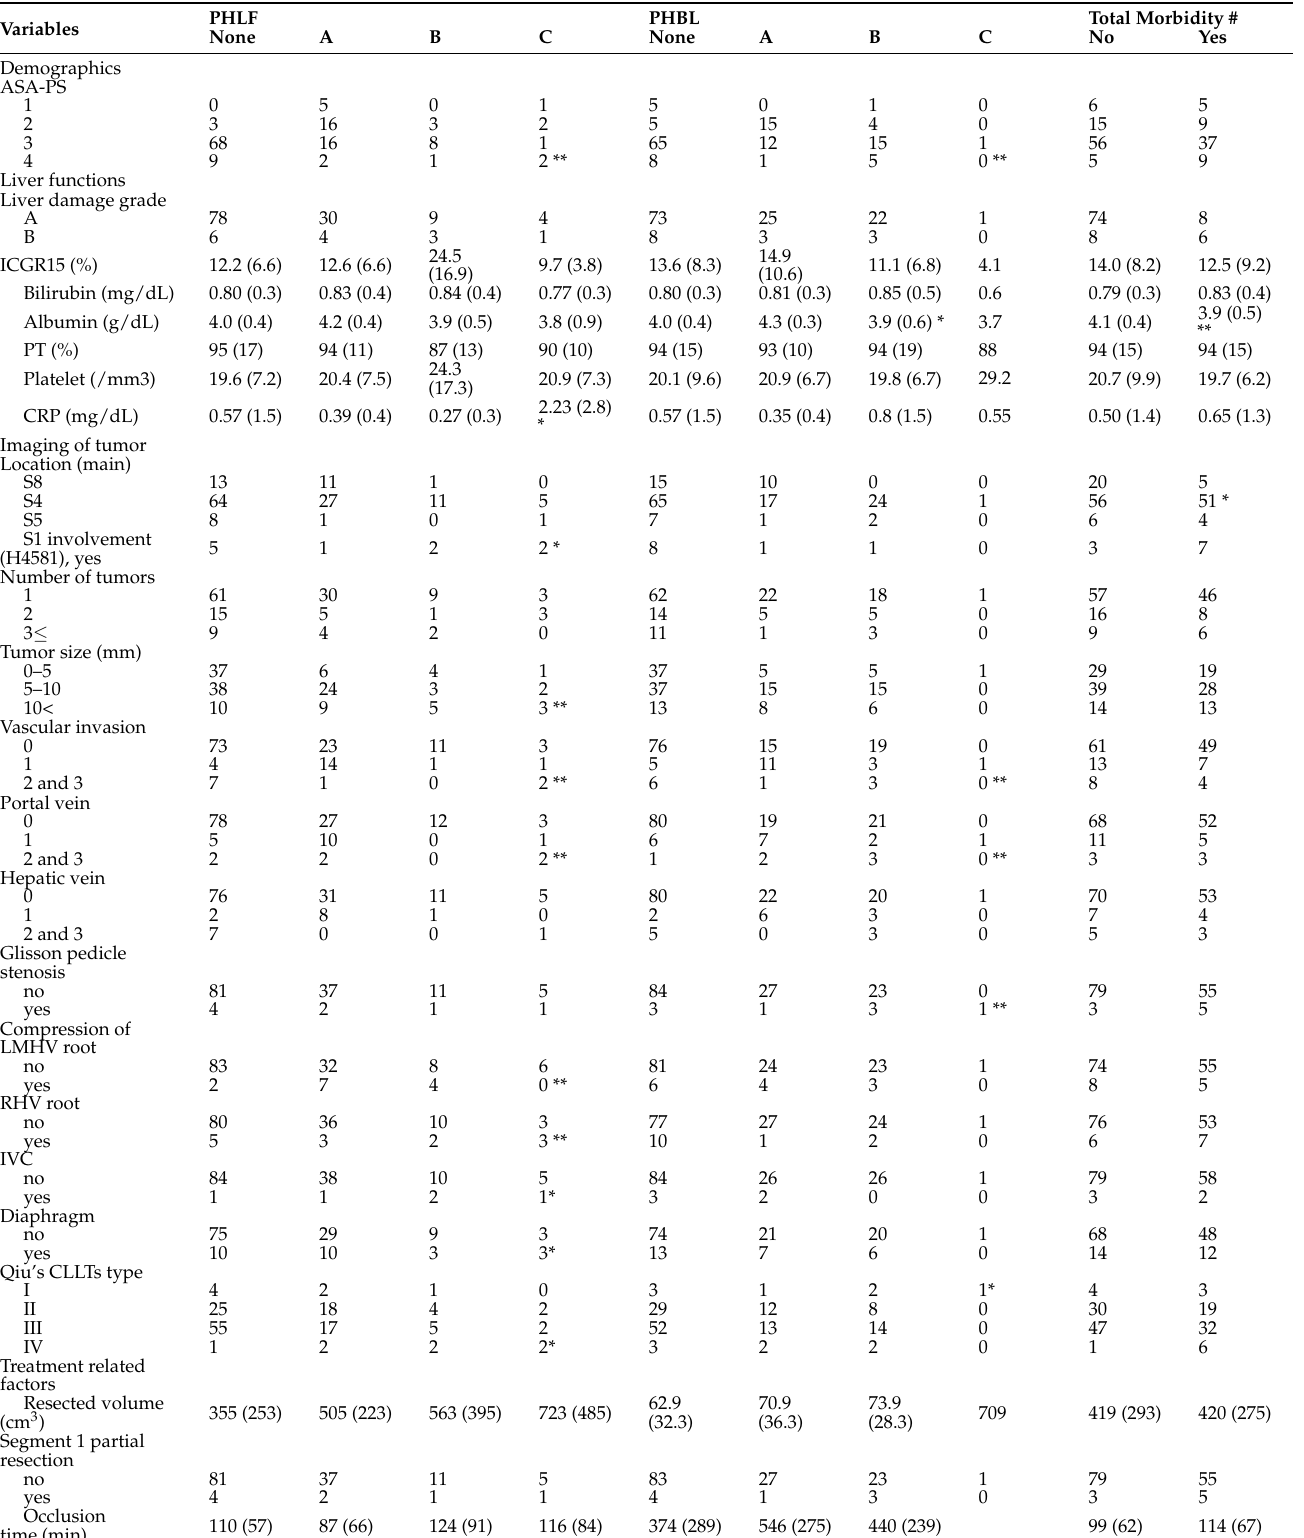
Table 2. Relationship between variables and postoperative major morbidities in 142 patients under- going CB